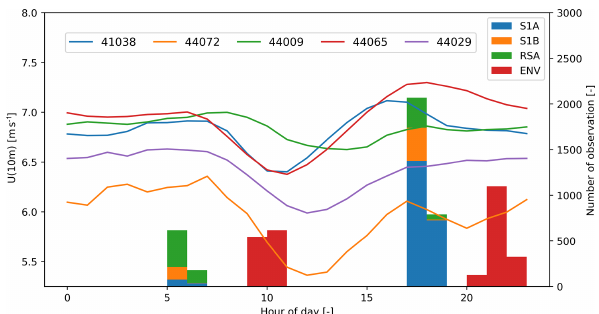
Figure 6. Mean wind speed of selected buoys in local time (UTC − 5). The bars indicate the number of satellite observations for RADARSAT (RSA), Envisat (ENV), Sentinel-1A (S1A), and Sentinel-1B (S1B). Table 2. Mean absolute error (MAE), root-mean-square er- ror (RMSE), and bias between mean wind speeds from buoys versus SAR, seasonally corrected SAR (SAR_SC), and WTK. MAE RMSE Bias SAR 0.51 0.63 0.34 SAR_SC 0.3 0.39 0.09 WTK 0.24 0.30